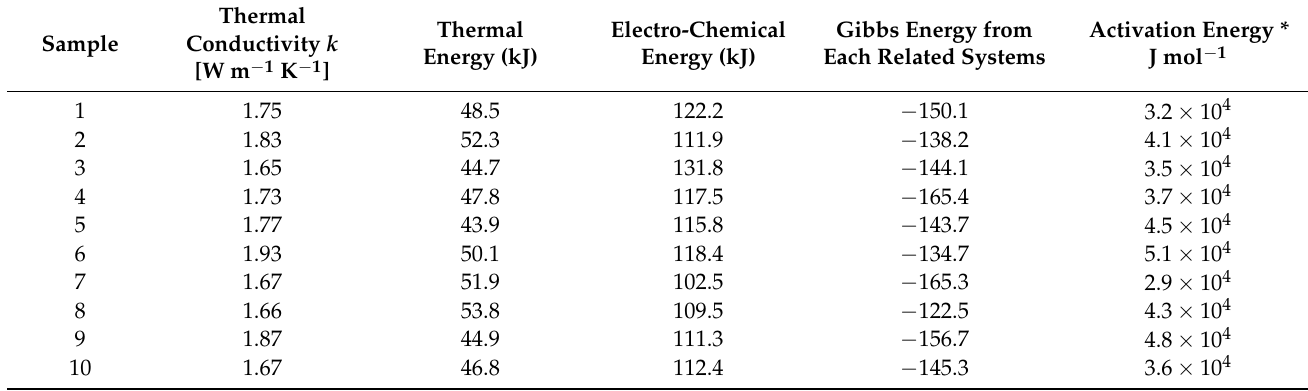
Table 5. Thermodynamic properties for 28 samples for the system (1-x-y) LiFe 0.333 Ti 0.333 Co 0.333 PO 4 , xLi 2 MnPO 4 and yLiFePO 4